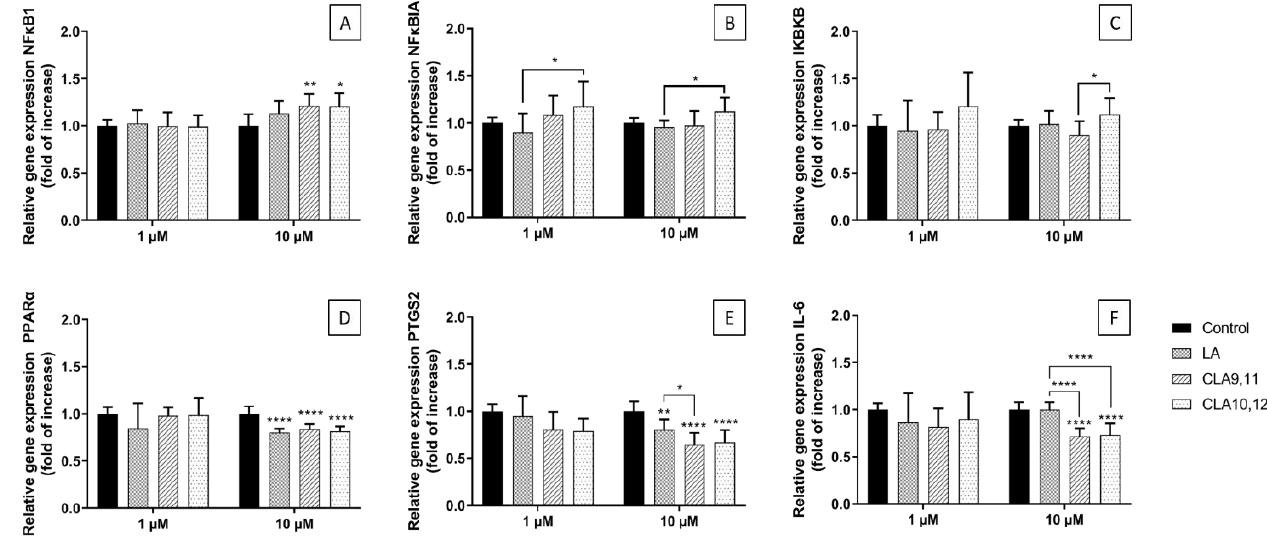
Figure 3. Expression of NF κ B1 ( A ), NF κ BIA (for I κ B α , ( B )), I κ BKB (for I κ K- β , ( C )), PPPAR- α ( D ), PTGS2 (for COX-2, ( E )) and IL-6 ( F ) genes in EA.hy926 cells preincubated for 48 h with 1 or 10 µM of fatty acid in a medium containing 0.1% of ethanol (Control) followed by incubation with a medium without fatty acids for 6 h. Cq values were normalized by the geometric mean of reference targets (YWHAZ and RPL13A genes). Bars are mean ± SD of 9 samples from 3 experiments. Data were analysed using the one-way ANOVA with Tukey’s post hoc test. * p < 0.05, ** p < 0.01, **** p < 0.0001; where asterisks are shown immediately above a bar they refer to the difference from the control and where asterisks are shown above a horizontal line they refer to the differences between the two groups indicated by that line. LA, linoleic acid; CLA9,11, cis -9, trans -11 linoleic acid; CLA10,12, trans -10, cis -12 linoleic acid.